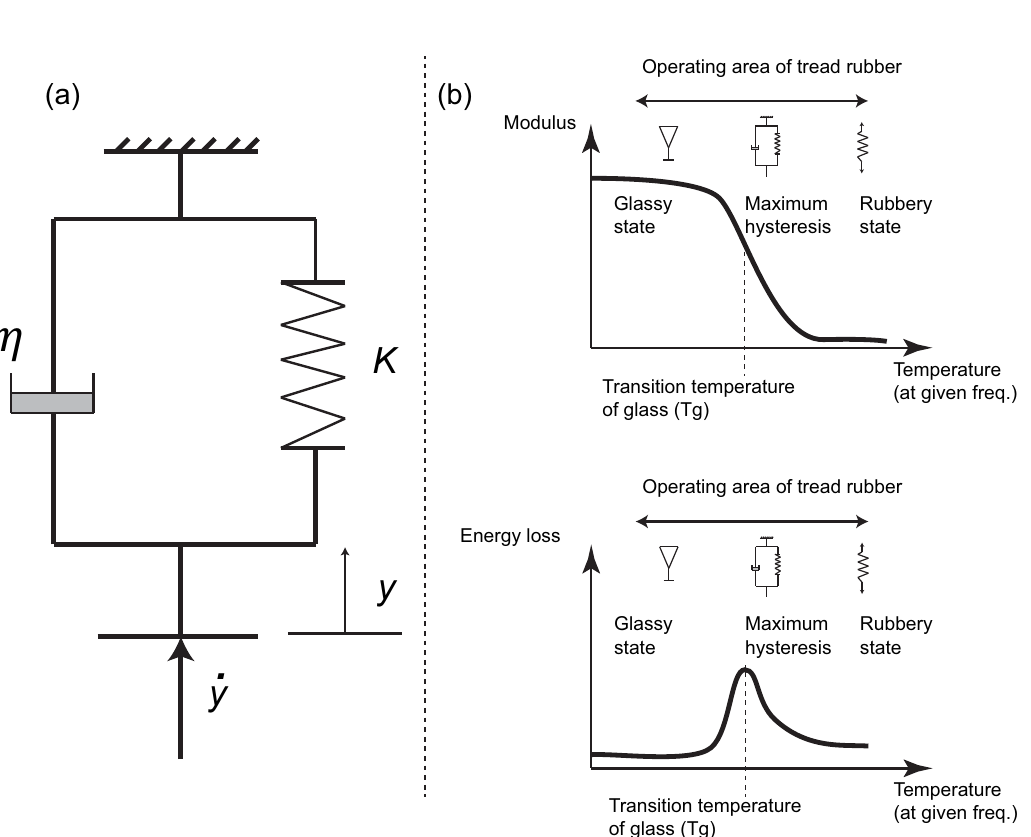
Figure 3. ( a ) The tyre as a viscoelastic material can be approximated as a spring K connected in parallel to a damper η ; ( b ) The influence of temperature on the tyre as a viscoelastic material. The modulus of elasticity is maximum for temperatures lower to the glass transition temperature. Hysteresis (energy loss) is maximum at the glass transition temperature